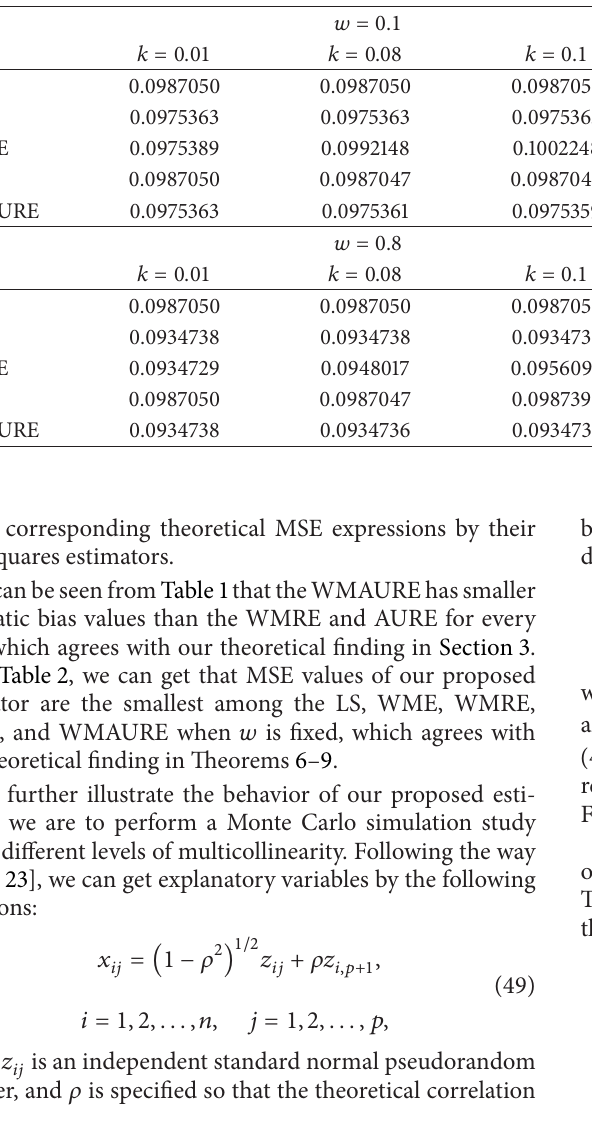
Table 4: Estimated MSE values of the WME, WMRE, AURE, and WMAURE when 𝜌 = 0.9